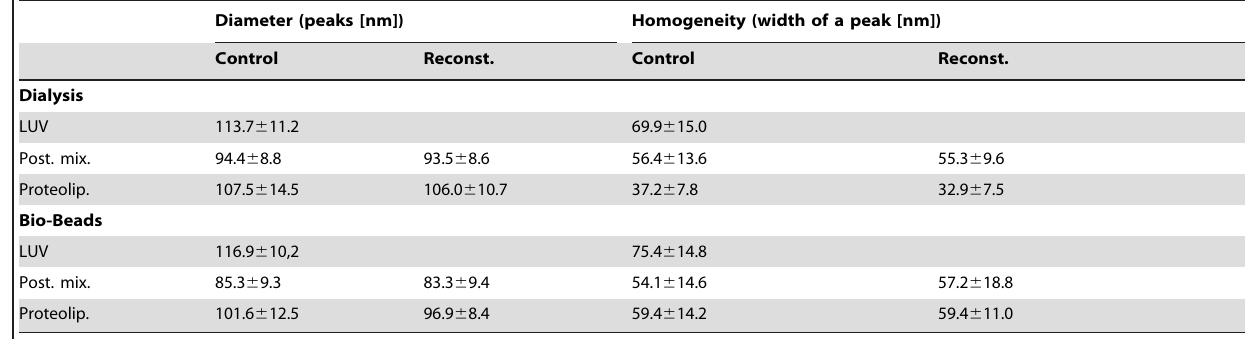
Table 1. Reconstitution of protein using SDS.